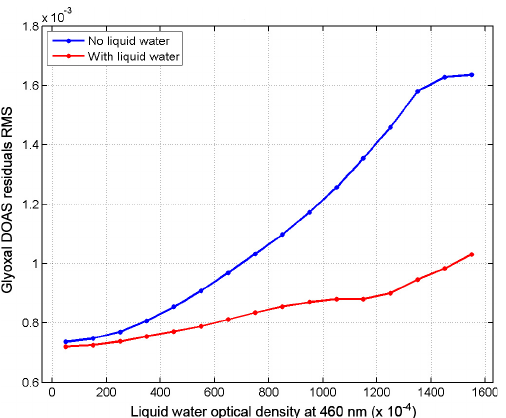
Fig. 3. Averaged root mean square of glyoxal DOAS residuals for all GOME-2 measurements of 5 December 2008 as a function of the liquid water optical density. Considering the liquid water absorption in the glyoxal retrievals significantly improves the fit quality.